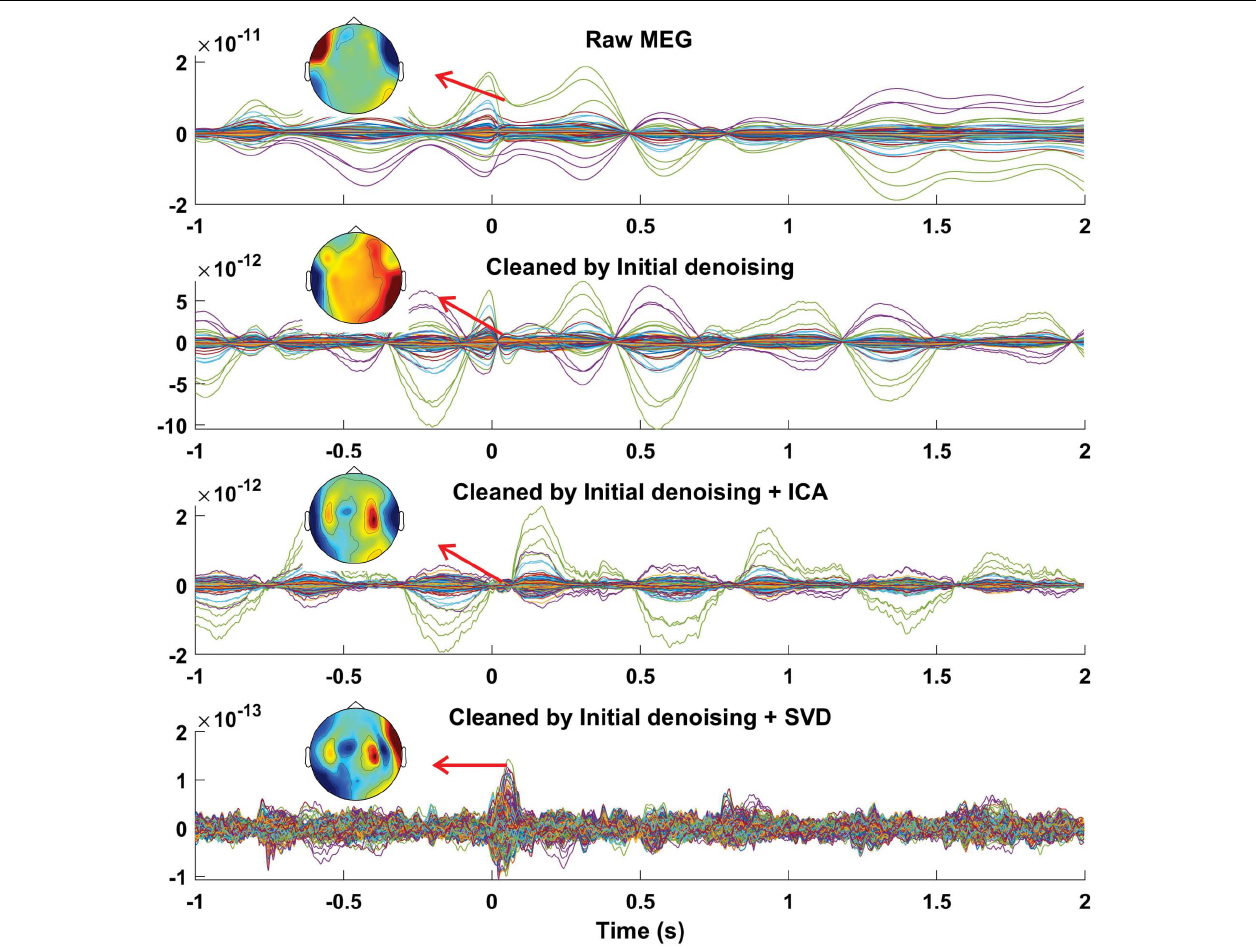
FIGURE 6 | MEG recording during speech production. Averaged, time-locked data across trials of all MEG sensors from one representative individual (participant #11) recorded during syllables pronunciation before artifact rejection (first panel), after cleaning by our initial denoising step, i.e., GLM-based analysis (second panel), after cleaning by ICA (third panel), and after cleaning by SVD (fourth panel). The distribution of the averaged MEG amplitude for a time period between 50 and 60 ms is displayed on the topographical maps for different conditions. The first row illustrates strong MEG data distortion which is distributed mainly in the temporal areas. The third row shows that ICA could not successfully remove the artifact and signals of interest are still not observable due to the residual artifacts. The fourth row, however, displays a clear pattern of neurophysiological activity after removing artifacts on the topoplot. Time point 0 s marks syllable pronunciation onset. The data shown here are from a participant with a